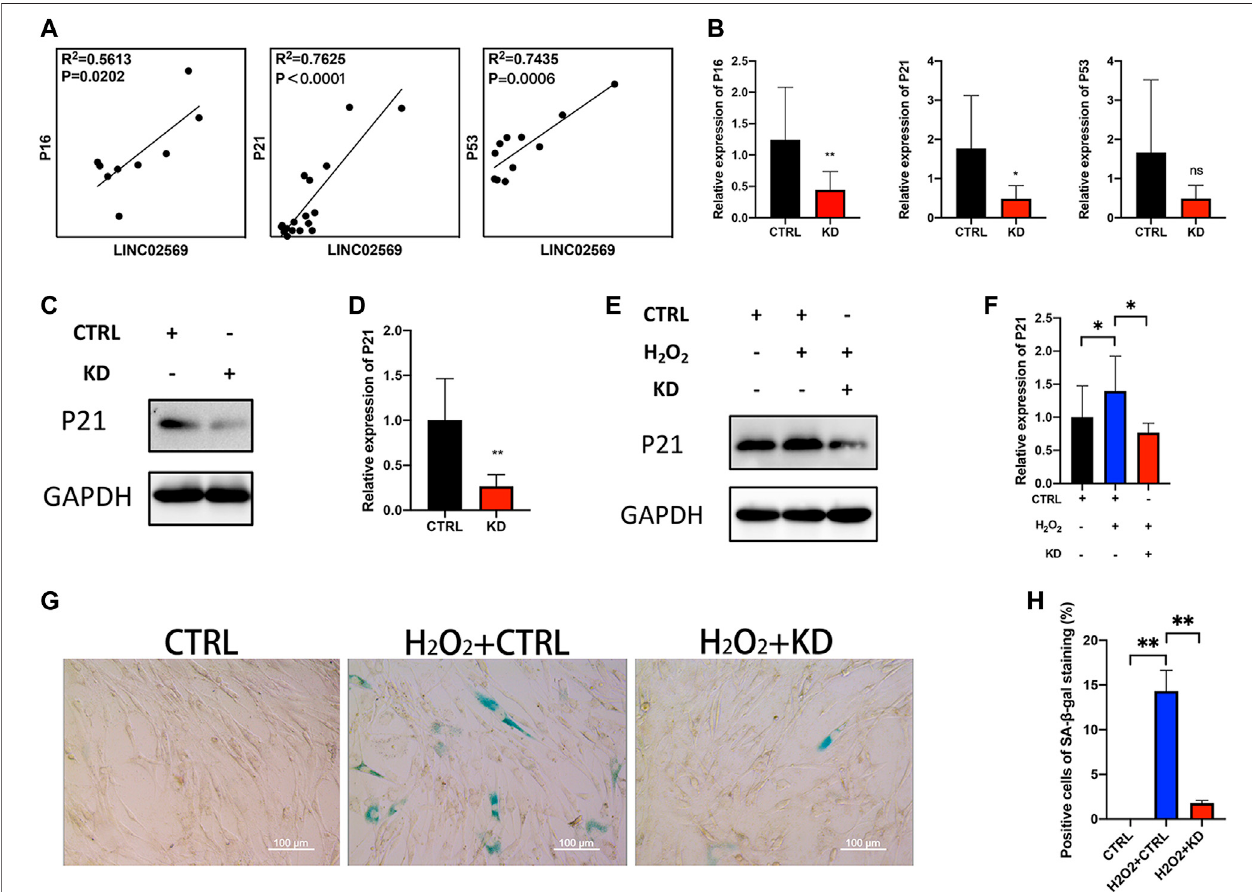
FIGURE 5 | Knockdown of LINC02569 alleviated NPCs senescence. (A) Scatter plot of qRT-PCR assay showed correlation of expression between LINC02569 and P16,P21and P53. R 2 and p valuesweredeterminedbyPearson ’ scorrelation test. (B) qRT-PCRassayofP16,P21andP53expression inLINC02569knockdown NPCs. (C,D) Protein levels of P21 determined by WB analyses of lysates from LINC02569 knockdown NPCs. (E,F) Protein levels of P21 determined by WB analyses of lysates from LINC02569 knockdown NPCs treated with H 2 O 2 . (G,H) Representative SA- β -gal staining of NPCs from different groups. Scale bar: 100 μ m. Quantitative results are from 3 independent experiments and are shown as the mean ± SD. p p < 0.05, pp p < 0.01.